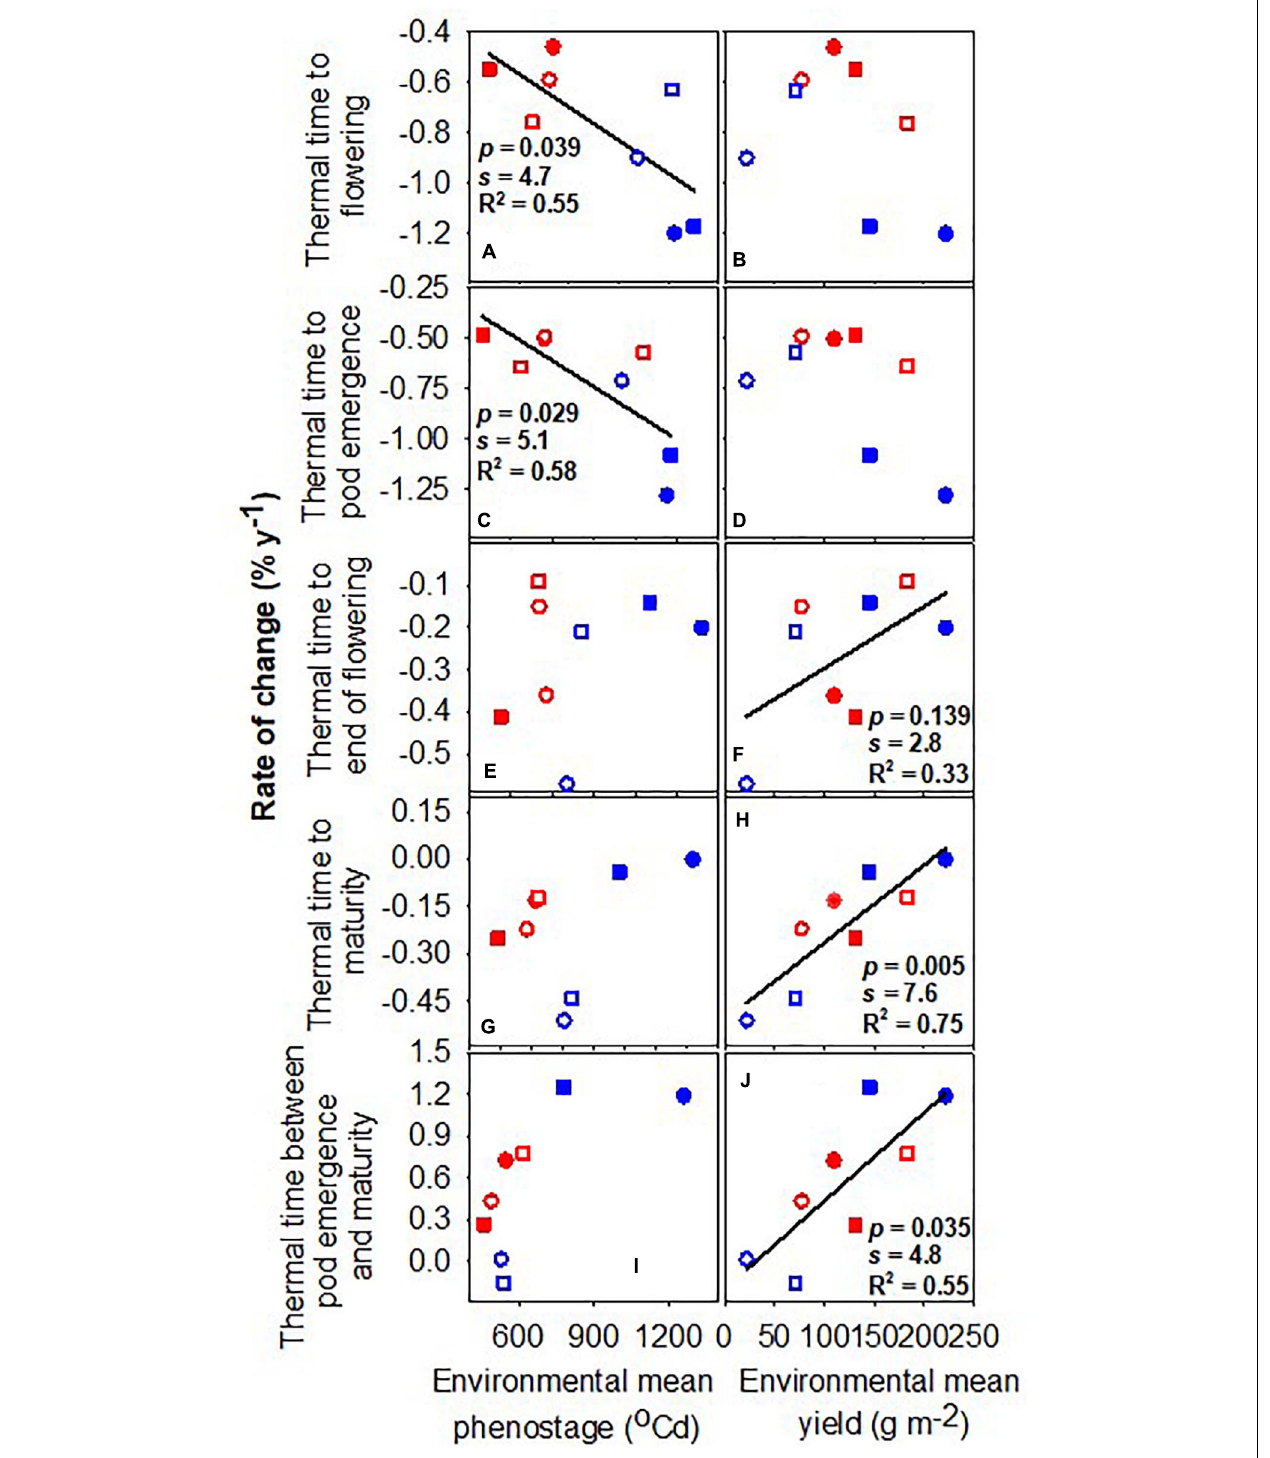
FIGURE 2 | Rate of change of thermal time from sowing to flowering, pod emergence, end of flowering and maturity, and the duration between pod emergence and maturity against the environmental mean phenostage (A,C,E,G,I) and the environmental mean yield (B,D,F,H,J) . Lines are least-square regressions and are only presented where p < 0.05, s > 4.3. Rates are relative to the newest variety. Symbols are: blue (2018), red (2019), circles (early sowing), square (late sowing), open (rainfed), closed (irrigated).